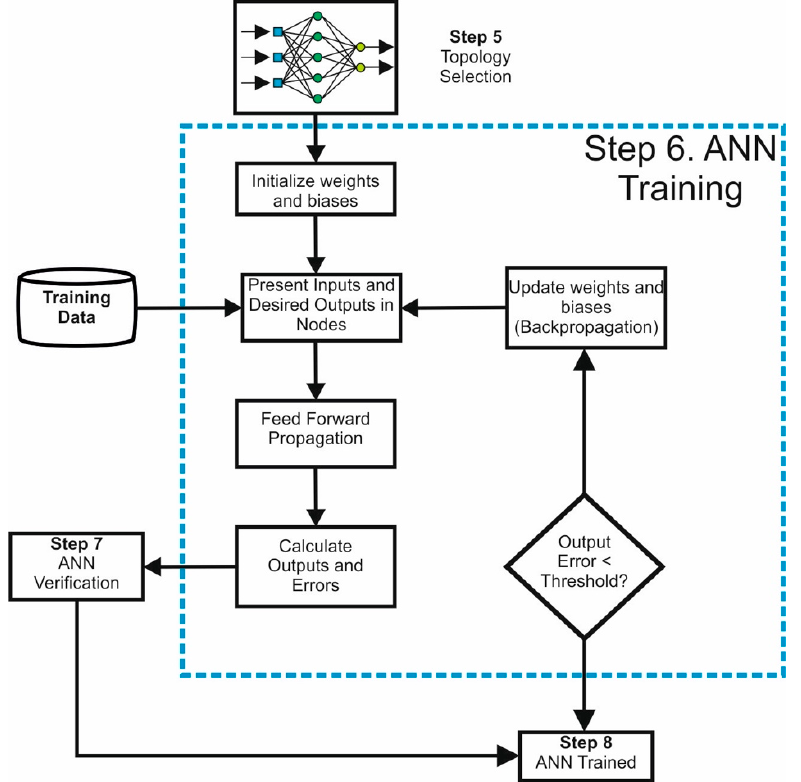
Figure 9. ANN Training Flowchart.